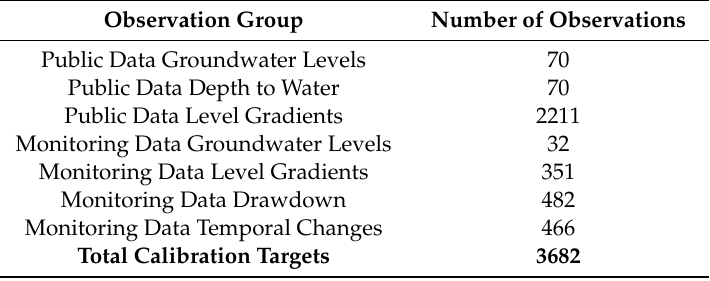
Table 1. Processed calibration targets for the groundwater